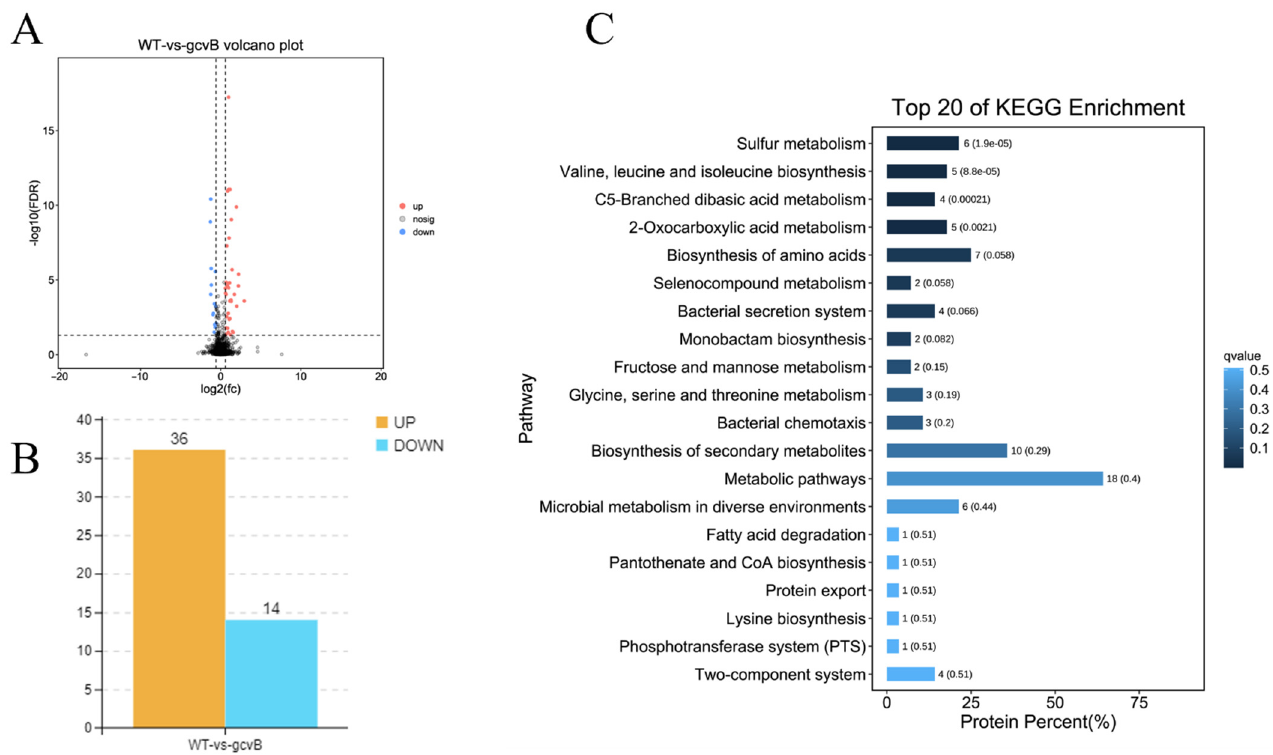
Figure 5. Overview of proteomic profiles of wildtype and gcvB mutant strains. ( A ) Volcanic map of differential genes in proteomics (FDR < 0.05, |fold change| ≥ 1.5). The red dot represents significantly up-regulated difference; the blue dot represents significantly down-regulated difference; the black dot represents no difference; ( B ) statistical column chart of differential expressed proteins. WT: wild-type strain Vibrio alginolyticus ZJ-T; gcvB : gcvB knockout strain ZJ-T- △ gcvB ; ( C ) histogram of top 20 of KEGG pathway enrichment in proteomics when gcvB was knockout.